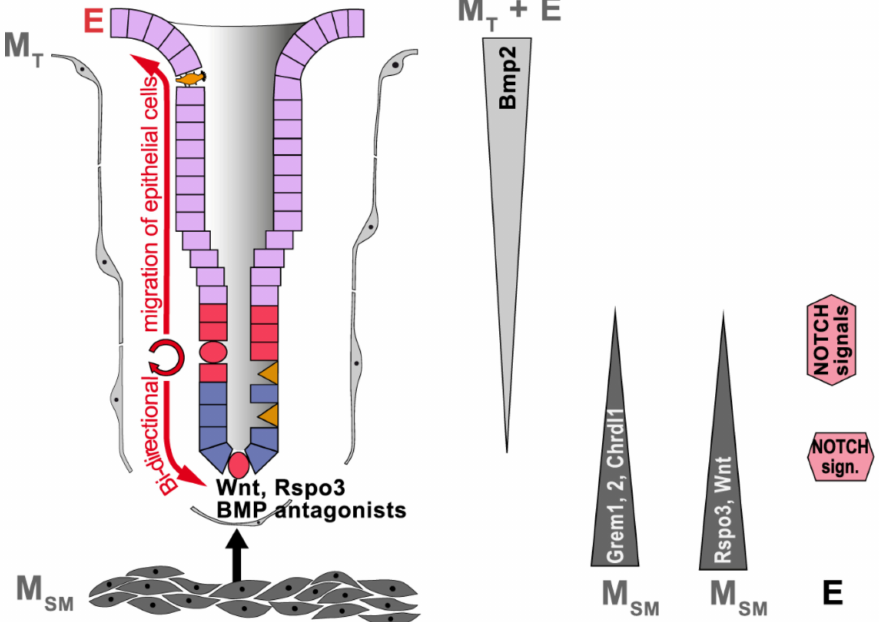
Figure 3. Schematic representation of reciprocal epithelial–mesenchymal interactions in the gastric antral unit as determined for the mouse. Shown are also gradients originating from the epithelium (E) or the mesenchyme (M; telocytes, M T ; smooth muscle cells, M SM ) concerning R-spondin 3, Bmp2, the BMP antagonists Gremlin 1, Gremlin 2, and Chordin-like 1 (Chrdl1) along the gland axis. Furthermore, the spatial organization of Notch signaling in the isthmus region and the gland base is